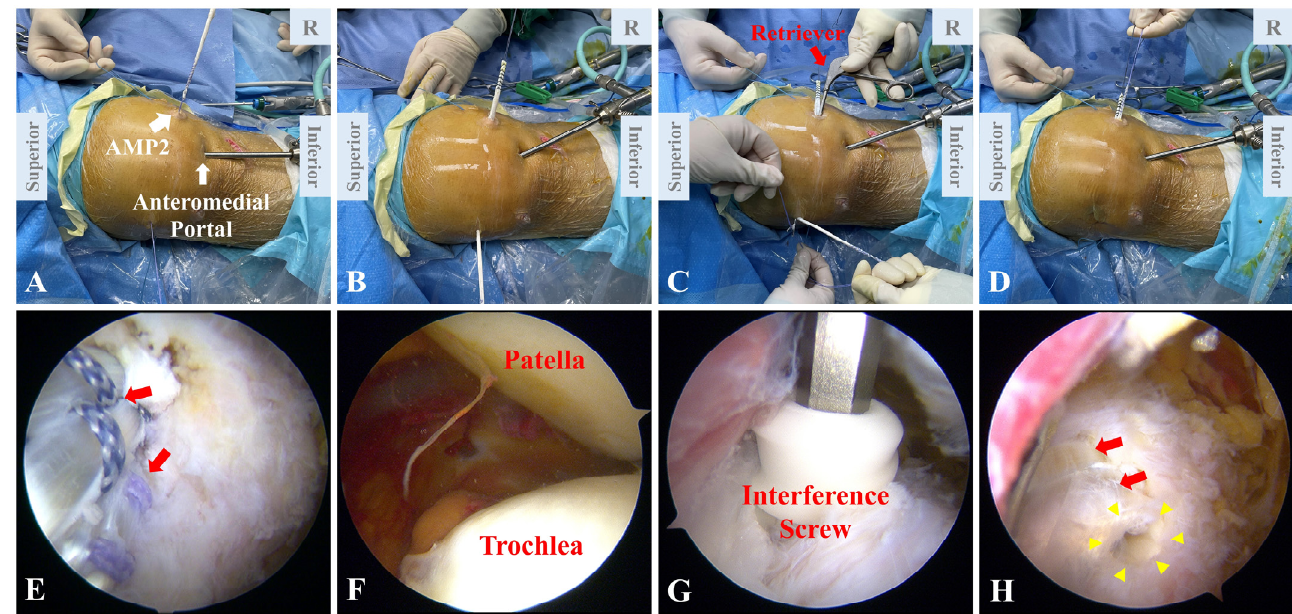
Figure 7. Autograft fixation. ( A , B ) Through the AMP2, the autograft is introduced into the patellar tunnel by guide sutures. ( C ) A retriever is introduced through the AMP2 to grasp the free end of the autograft. ( D ) The two ends of the autograft are pulled out through the AMP2, forming a double-bundle structure. ( E ) The double-bundle autograft (red arrows) is inserted into the femoral tunnel along the guide sutures. ( F ) Arthroscopic inspection demonstrates restored patellofemoral congruence. ( G ) A bioabsorbable interference screw is used to secure the femoral fixation. ( H ) The double-bundle autograft (red arrows) is fixed in the femoral tunnel with an interference screw (yellow triangles). AMP, auxiliary medial portal.